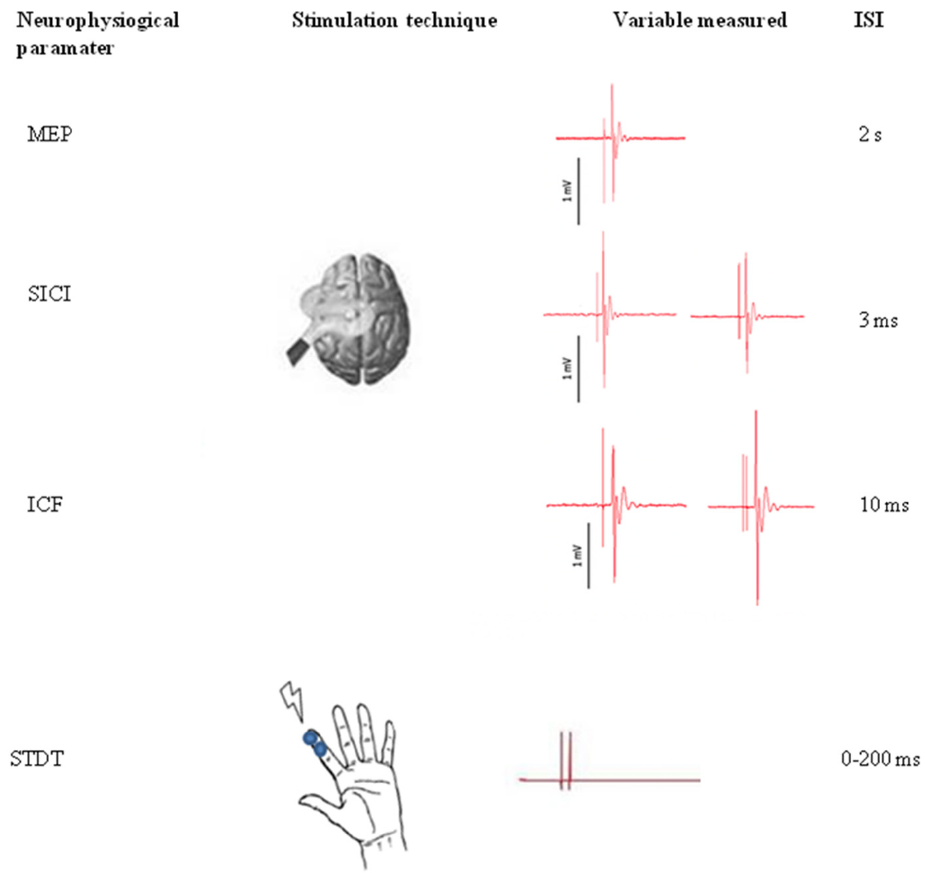
Figure 1. Experimental paradigm. Transcranial magnetic assessment: To elicit motor evoked potentials from the contralateral first dorsal interosseous muscle, single- and paired-pulse transcranic magnetic stimulation (TMS) were delivered on the motor area of the right hand. Paired-pulse TMS was delivered using an interstimulus interval (ISI) of 3 ms (short intracortical inhibition, SICI) and 10 ms (intracortical facilitation, ICF). Somatosensory temporal discrimination threshold: pairs of electric stimuli were delivered on the volar skin of the right index finger. Starting from an ISI of 0 ms (simultaneous stimuli), 10 ms steps were performed until participants were able to recognize the two stimuli as temporally separate.